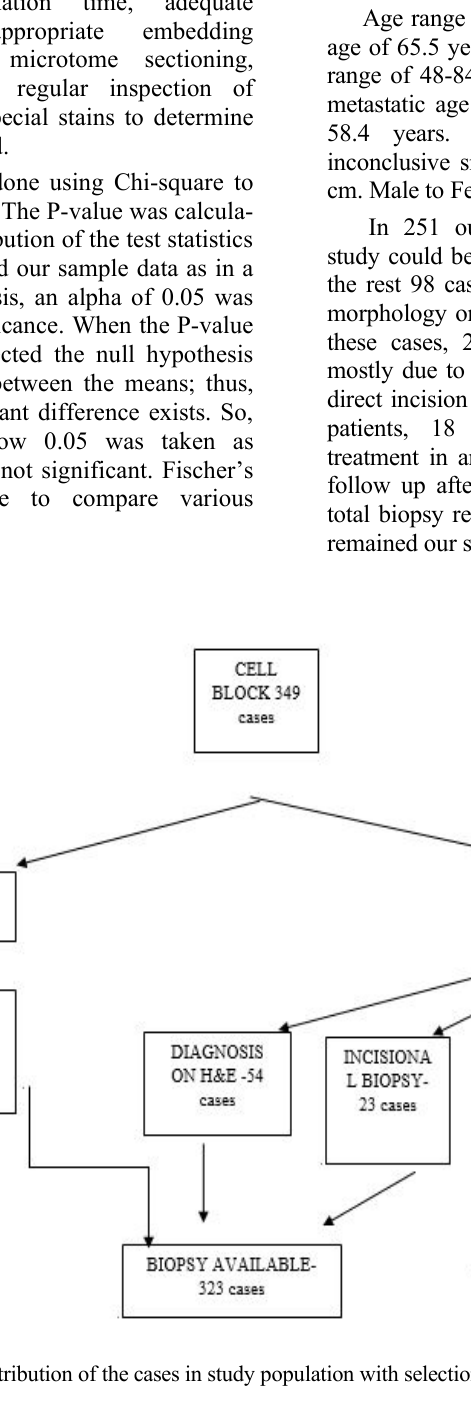
Fig. 2. Distribution of the cases in study population with selection of sample